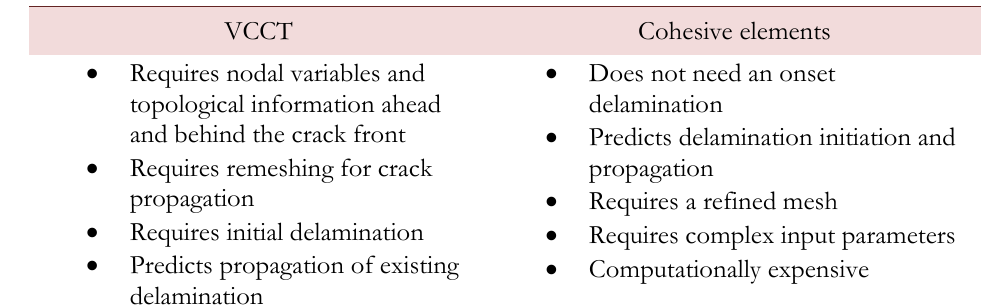
Table 2: Summary of main features of VCCT and cohesive elements techniques Finite element model